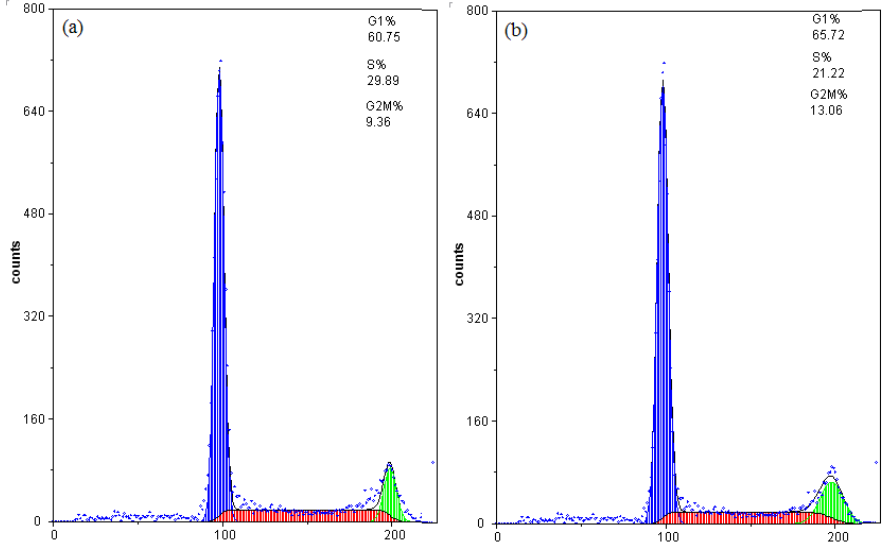
Figure 3. Cell cycle distribution of A549 cells after treatment with different concentrations of chamaejasmine for 48 h. ( a ) treatment with 0 µM chamaejasmine; ( b ) treatment with 2 µM chamaejasmine; ( c ) treatment with 4 µM chamaejasmine; ( d ) treatment with 8 µM chamaejasmine. Blue = G1; red = S; green =